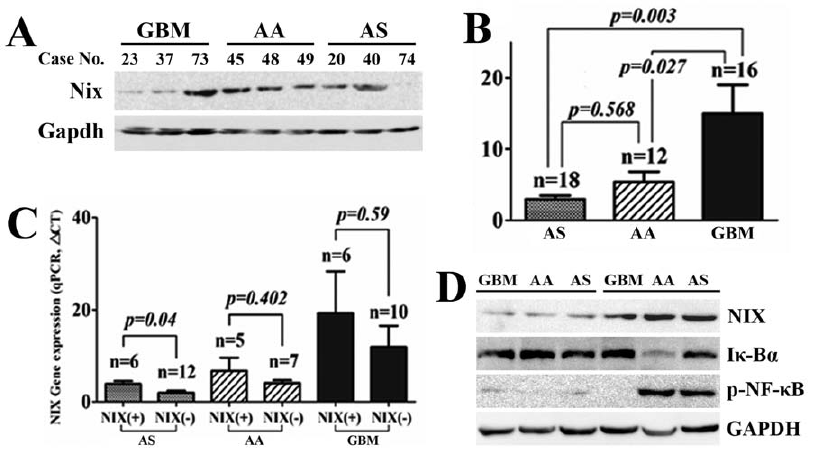
Figure 3. Nix protein and mRNA levels in 46 clinical glioma samples. ( A ) There was high expression of Nix protein (ratio of Nix/Gapdh . 1) in 17 cases, referred to as Nix ( + ). In this figure, 4 cases of Nix ( + ) (cases No. 73, 45, 48, and 40) and 5 cases of Nix ( 2 ) (cases No. 23, 37, 49, 20, and 74) were observed according to the ratio of Nix/Gapdh. ( B ) The highest NIX mRNA levels were observed in GBM patients, compared to AS and AA patients. ( C ) Asynchronous expression of NIX mRNA and protein. A significant difference in Nix mRNA levels between Nix ( + ) and Nix ( 2 ) cases was seen in AS samples ( p=0.04 ), but not in grade III and grade IV patients. The results suggested that posttrancriptional regulation of the NIX gene predominantly existed in malignant gliomas. ( D ) High expression of Nix protein consistently accompanied high p-NF- k B and low I- k B a expression in glioma samples.